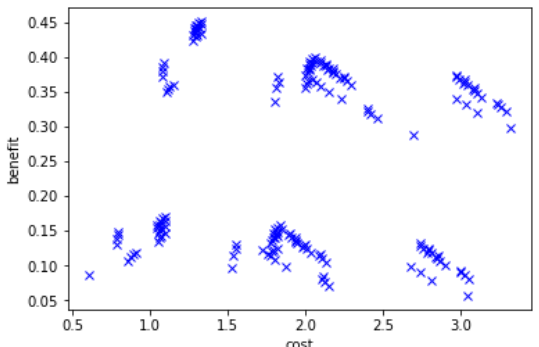
Figure 7. 6A (environmental issues + economic aspects).